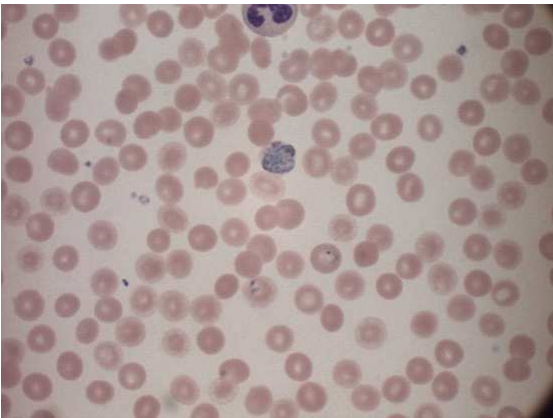
Figure 4. Sample image from the dataset.